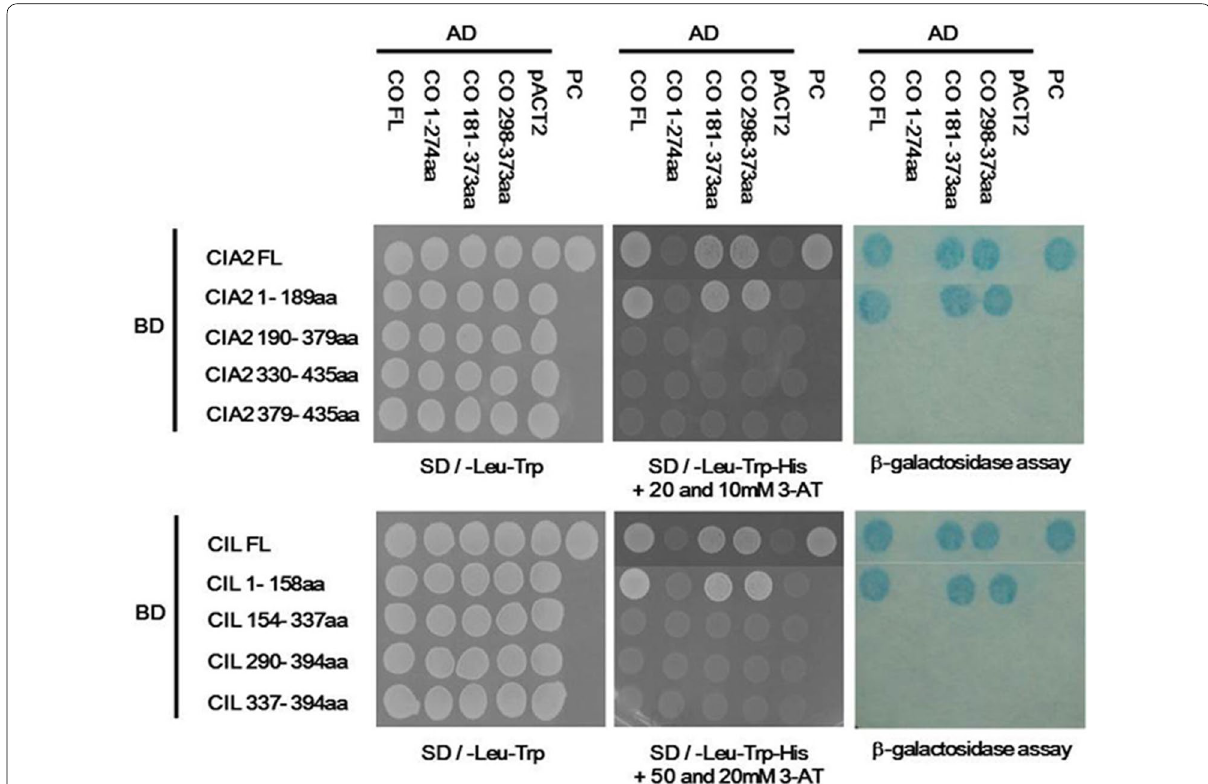
Fig. 5 Interactions between CIA2/CIL and CO, as assessed by Y2H assay. Vectors pAS2‑1 and pACT2 harbor GAL4 BD and GAL4 AD, respectively. The CIA2 and CIL fragments were ligated into pAS2‑1 vector. The full‑length CO fragment was ligated into pACT2 vector. Colonies were assayed for SD/‑Leu‑Trp autotrophy, SD/‑Leu‑Trp‑Trp 20 or 50 mM 3‑AT autotrophy, and β‑galactosidase activity. pACT2, negative control. PC, positive control + containing pVA3‑1 and